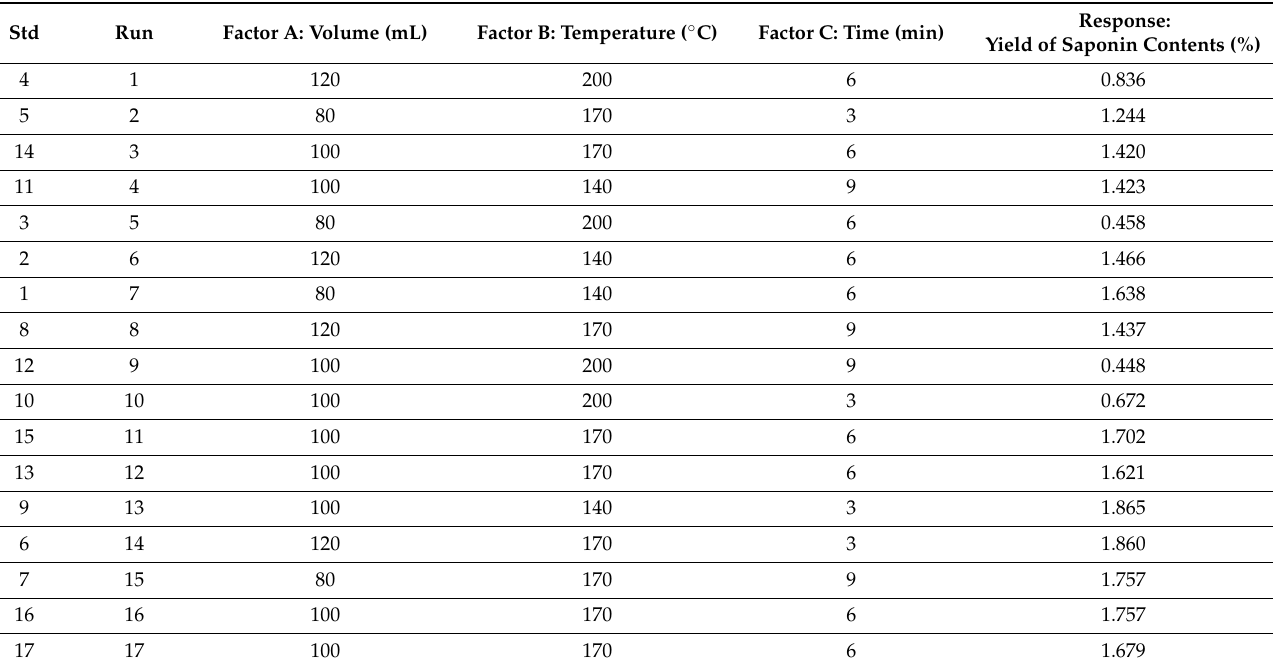
Table 2. Experimental results for the response value.